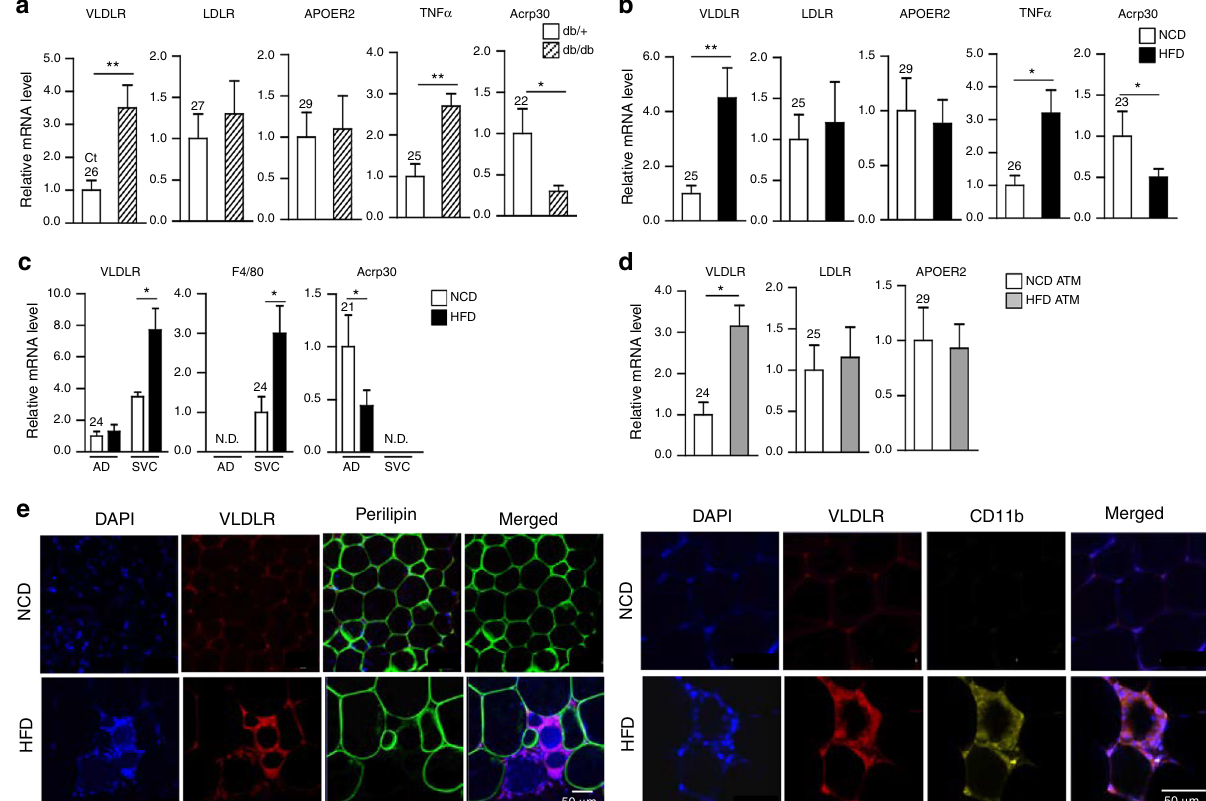
Fig. 1 VLDLR expression is elevated in ATMs from obese mice. a , b Relative mRNA level of VLDLR in adipose tissue of a lean ( db/ +) ( n = 4) and obese ( db/db ) ( n = 5) mice and b normal chow diet (NCD)-fed ( n = 6) and high-fat diet (HFD)-fed ( n = 7) mice as measured by RT-qPCR. c Relative mRNA level of VLDLR in adipocyte (AD) and stromal vascular cell (SVC) fractions from NCD-fed ( n = 5) and HFD-fed ( n = 5) mice. d Relative mRNA level of VLDLR in sorted ATMs (F4/80 + , CD11b + ) from NCD-fed ( n = 12) and HFD-fed ( n = 9) mice. a – d Each mRNA level was normalized to cyclophilin mRNA. Data represent the mean ± SD. * P < 0.05, ** P < 0.01, Student ’ s t -test. e VLDLR protein was monitored in ATMs from NCD-fed and HFD-fed mice. Whole-mount immunohistochemistry analysis of the nucleus (blue), VLDLR (red), perillipin (green), and CD11b (yellow) in EATs from NCD-fed and HFD-fed